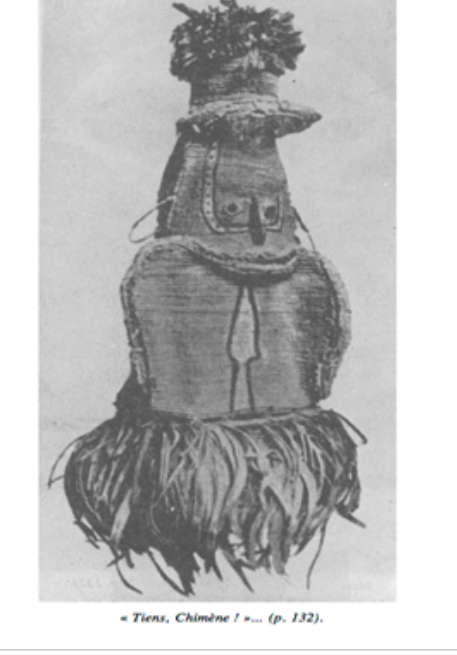
Figure 11. Anonymous. Photograph of Conical Mask from New Brittany in Nadja